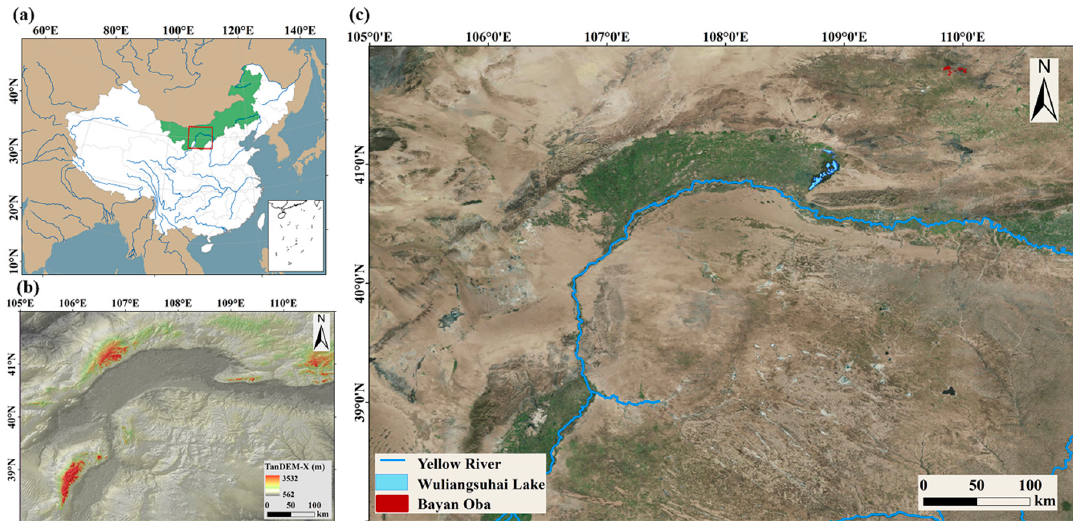
Figure 1. Study area in the southwestern Inner Mongolia Autonomous Region in northern China. ( a ) The location of the study area in southern Inner Mongolia Autonomous Region, China. ( b ) The study area in relation to the TanDEM-X scene. ( c ) The study area in true color image with the Yellow River, Wuliangsuhai Lake, and Bayan Obo Mining District.